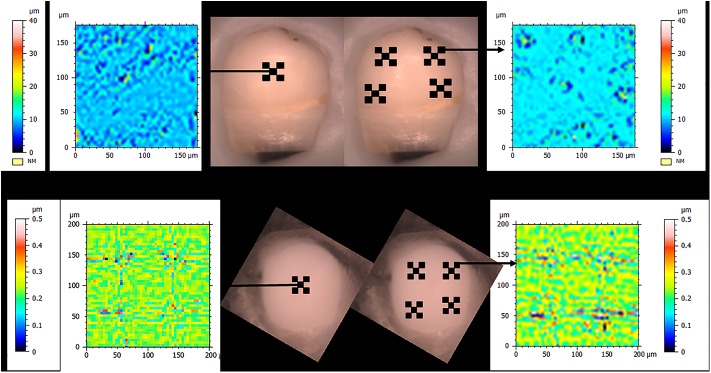
Representative diagrammatic images of an unpolished and polished enamel sample with the 5 scan areas for the central cluster and 20 scan areas for the peripheral cluster mapped out separately.A representative baseline scan image for the central cluster and peripheral cluster are also shown for each sample.